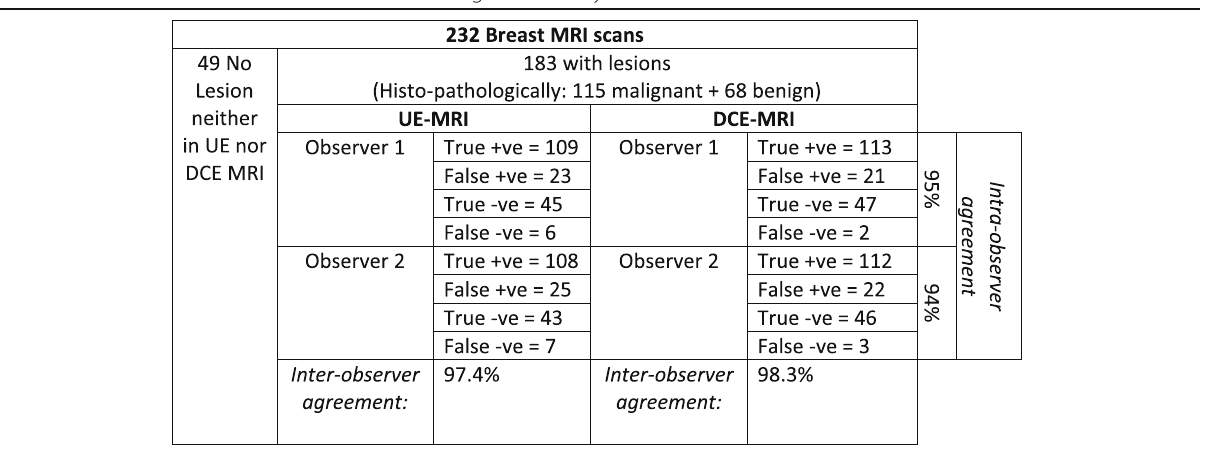
Table 1 The distribution of the results after reviewing the scans by two